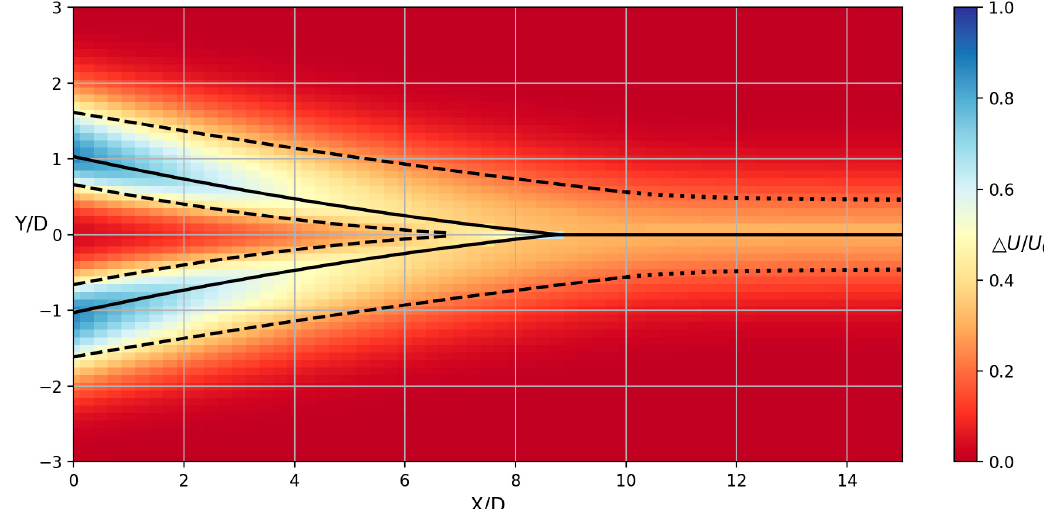
Figure 5. The velocity contour of Case 3 (Counter-rotating twin turbines (forward)). The color bar is the velocity deficit, the black solid lines represent the position of the maximum velocity deficit, and the black dashed lines represent the deviations of the double semi Gaussian functions.